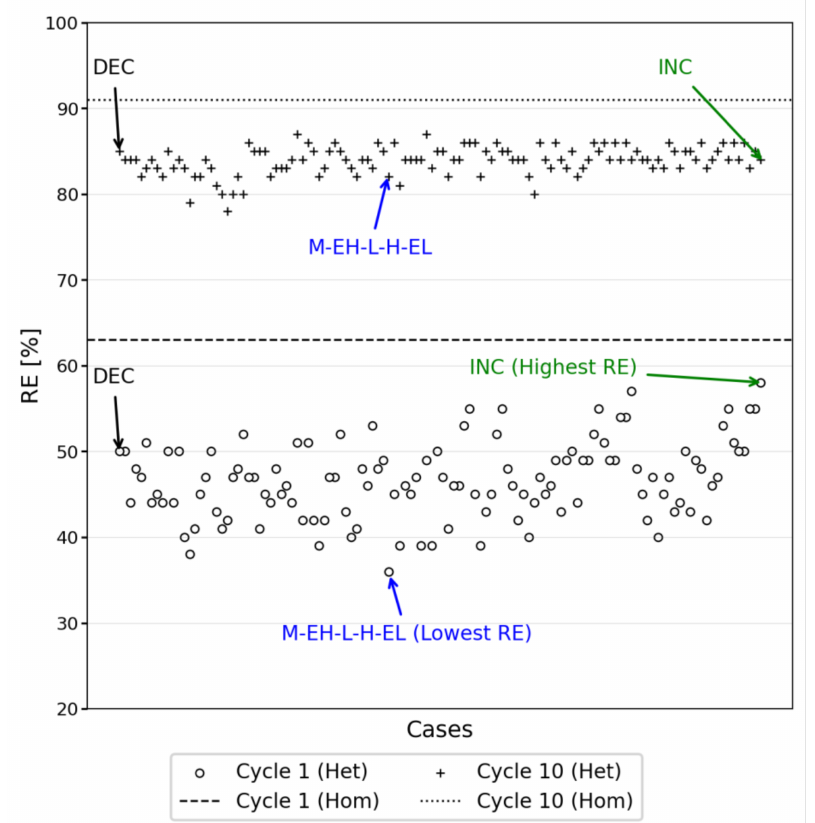
Figure 8. RE values assessed at the first and tenth cycles, for heterogeneous cases of all possible arrangements of the five isotropic layers (‘Het’, scattered points) and the homogeneous anisotropic case (‘Hom’, lines).